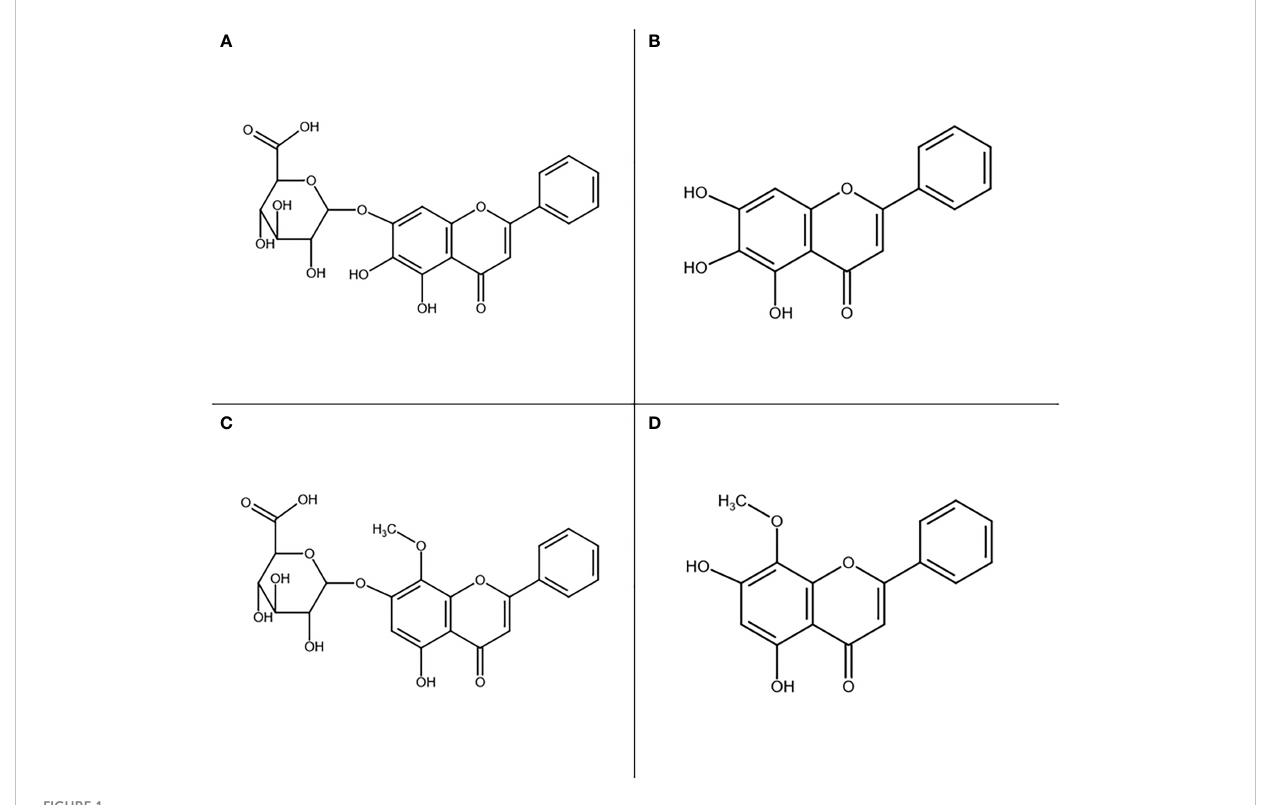
FIGURE 1 Main active compounds found in Sb root: baicalin (A) , baicalein (B) , wogonoside (C) , and wogonin (D)